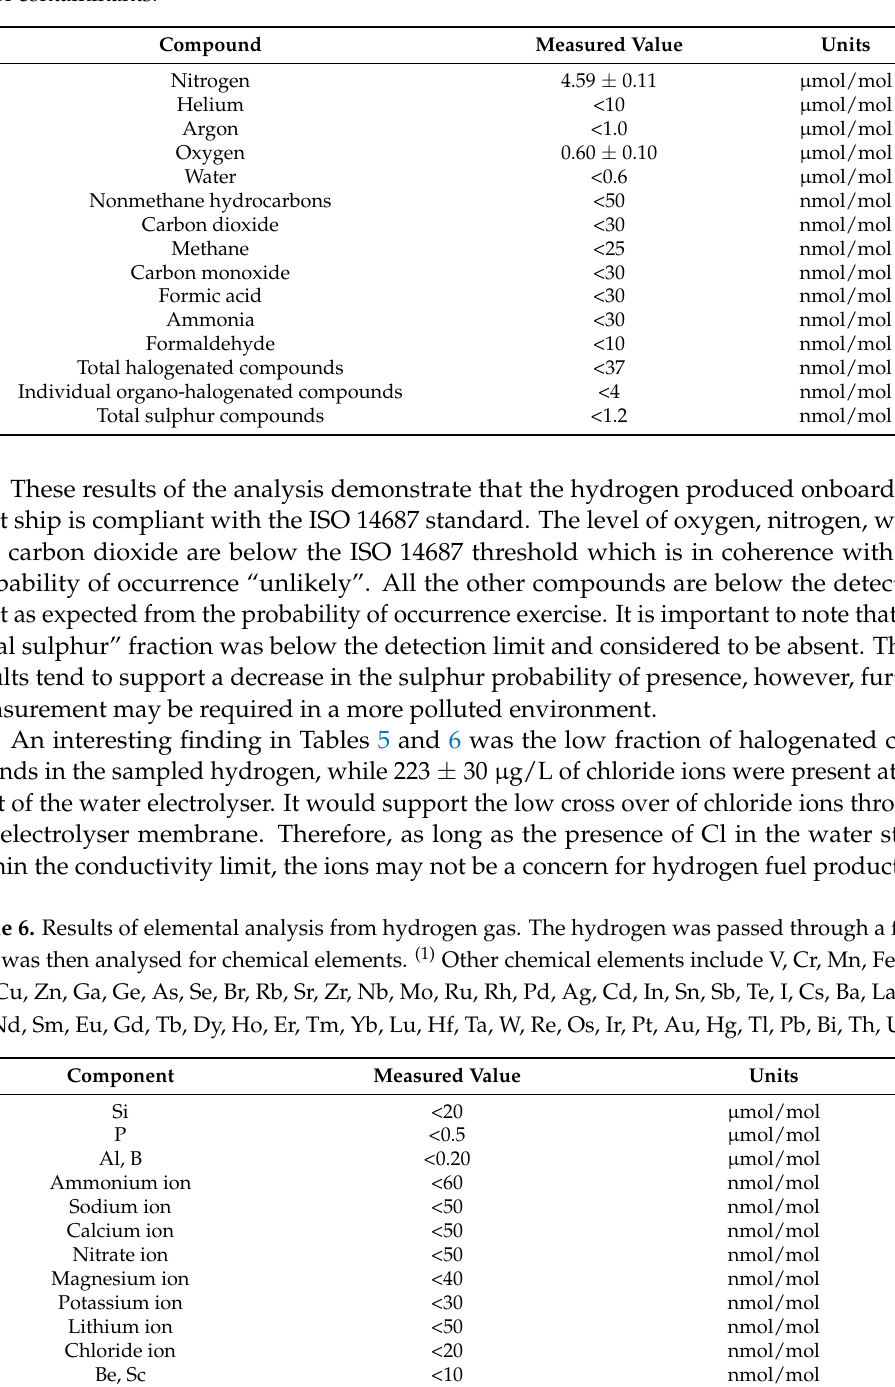
Table 5. Results of hydrogen gas quality from ship onboard electrolyser according to ISO 14687:2019 list of contaminants.